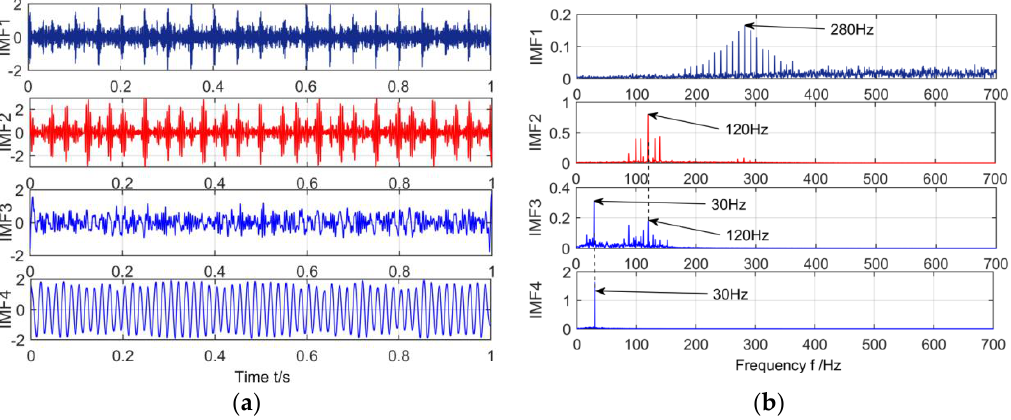
Figure 6. The spectrum of IMFs after Ensemble Empirical Mode Decomposition (EEMD) and its corresponding spectrum. ( a ) Time domain of IMFs after EEMD; ( b ) The spectrum corresponding to each layer of IMF.